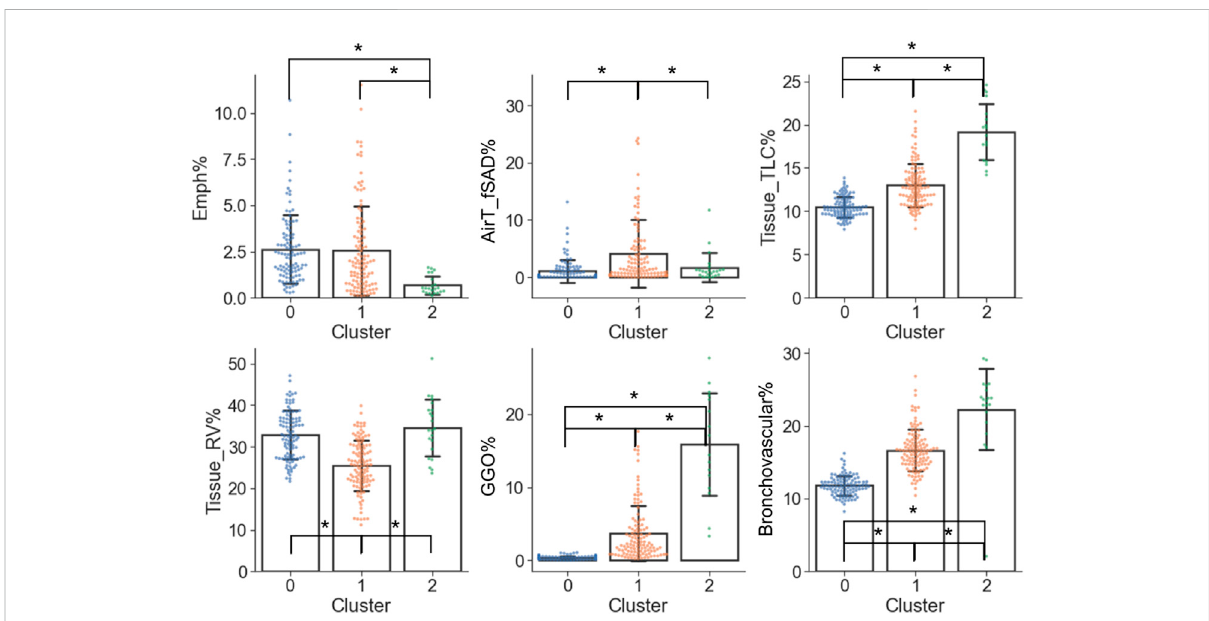
FIGURE 6 Imaging variables which were signi fi cantly different ( α = 0.05) between the clusters. A “ * ” denotes signi fi cance between two clusters and the range of error bar is the mean ± the standard deviation.